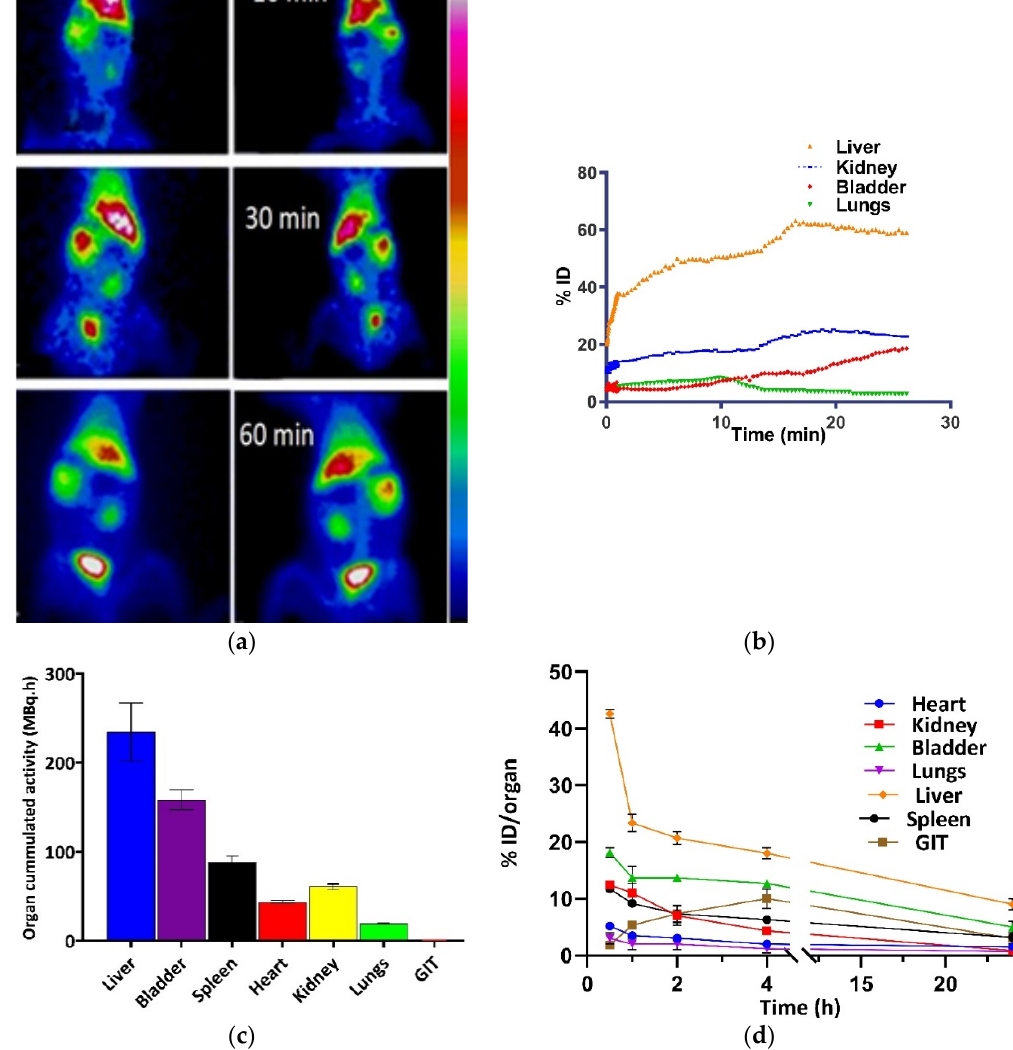
Figure 4. Biodistribution and kinetics of 99mTc Q9P35GC micelles in rabbits. ( a ) Representative SPECT images were taken by Dual-Head Gamma Camera (Anterior: right and Posterior: left) after IV administration of 99mTc Q9P35GC micelles at 10, 30, and 60 min; ( b ) Average SUV TACs in liver, kidney, and bladder during initial 25 min after IV administration of 80 ± 2 MBq of 99mTc Q9P35GC micelles, represented as mean ± SD, n = 5; ( c ) Organ cumulated activity following intravenous bolus injection of 99mTc Q9P35GC micelles (80 ± 2 MBq) expressed as MBq.h of tissue in different organs ( n = 3); ( d ) In vivo biodistribution following an intravenous bolus injection of 99mTc Q9P35GC micelles expressed as percentage injected dose with SEM in different organs at different time points. Error bars show SD.